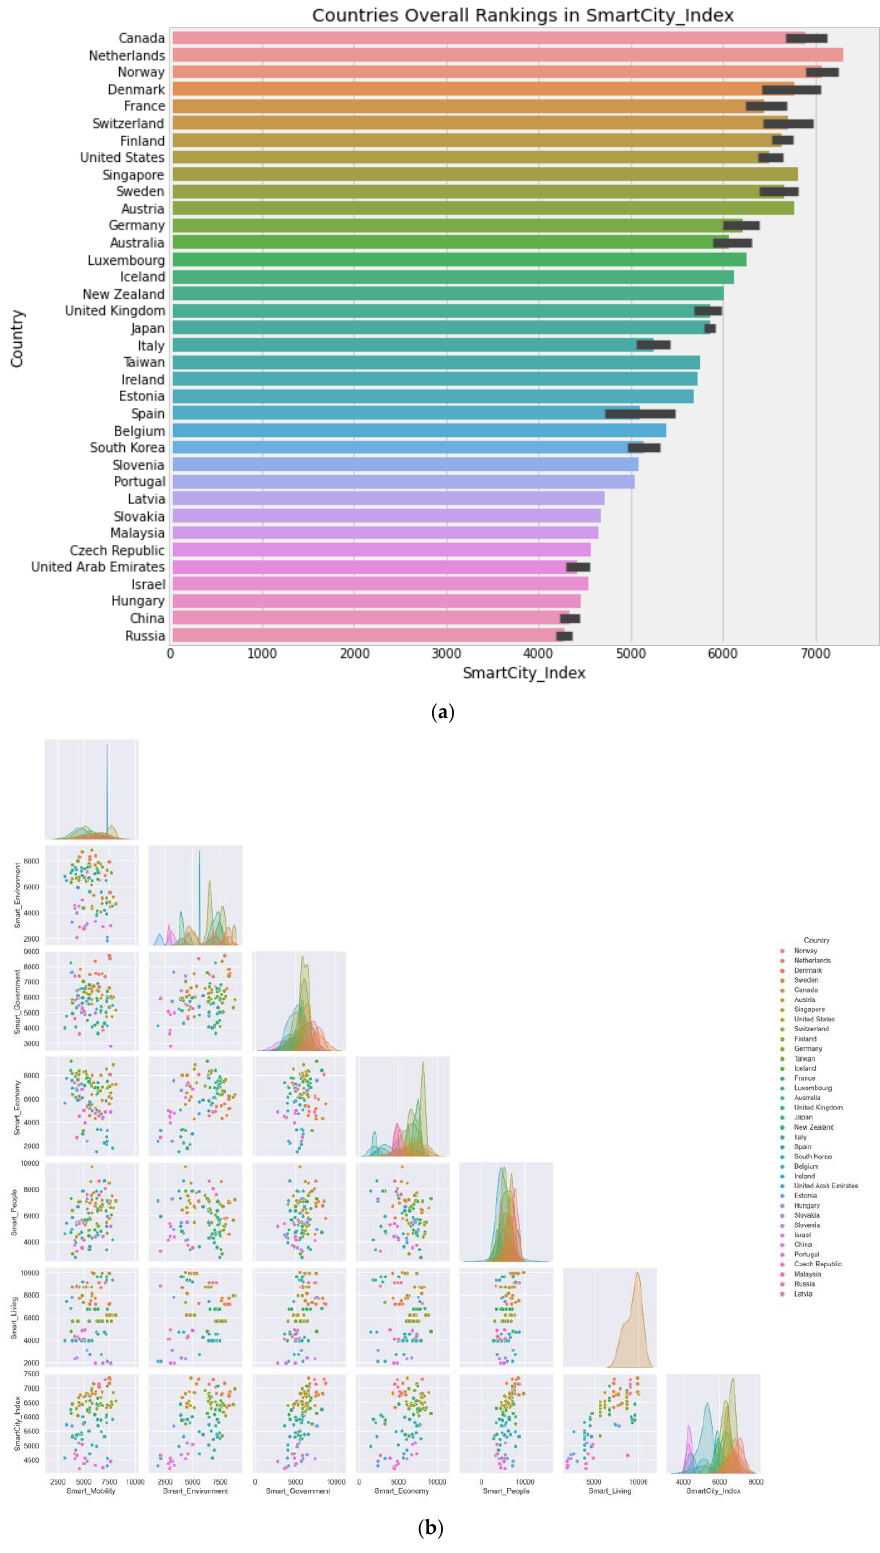
Figure 1. ( a ) Countries’ Overall rankings in Smart City Index ( b ) Smart City Index categories and correlations with overall Smart City score.